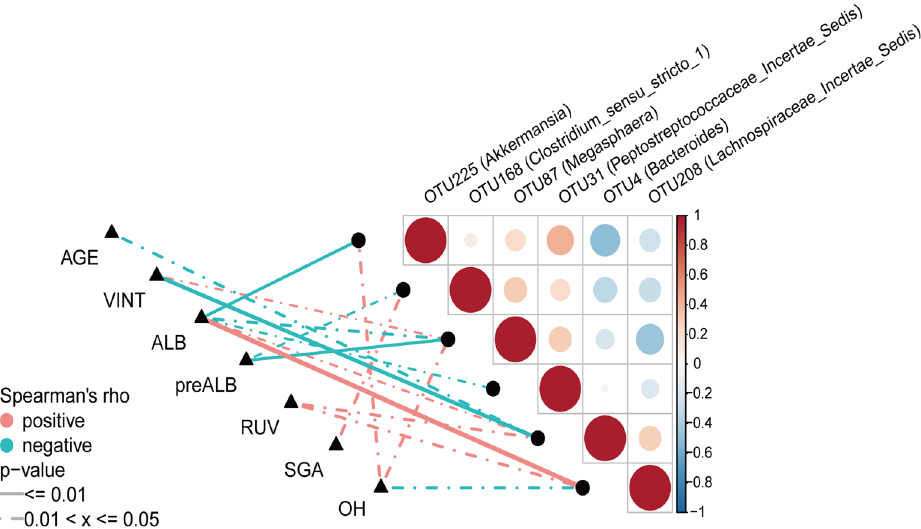
Figure 4. Correlation of abundant bacteria on OTU level with nutrition in the whole group of 30 CAPD patients based on Spearman correlation analysis. CAPD continuance ambulatory peritoneal dialysis, VINT vintage, ALB albumin, preALB pre-albumin, RUV residual urine volume, SGA subjective global assessment, OH over